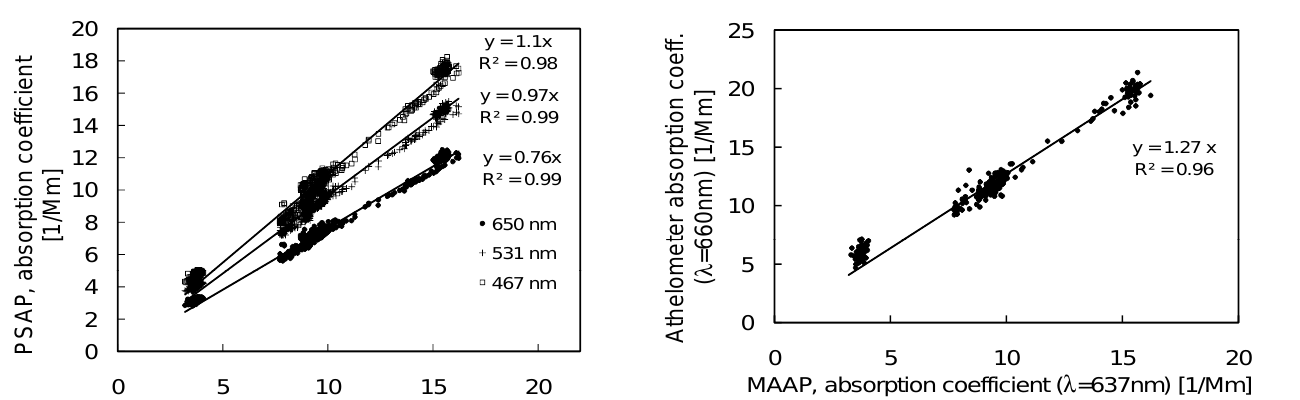
Fig. 6. Ambient air runs during GAW2005. PSAP absorption co- efficients vs. MAAP absorption coefficients (637nm) for the three PSAP wavelengths. The linear regression is forced through the ori- gin. PSAP data were corrected using the Bond correction.